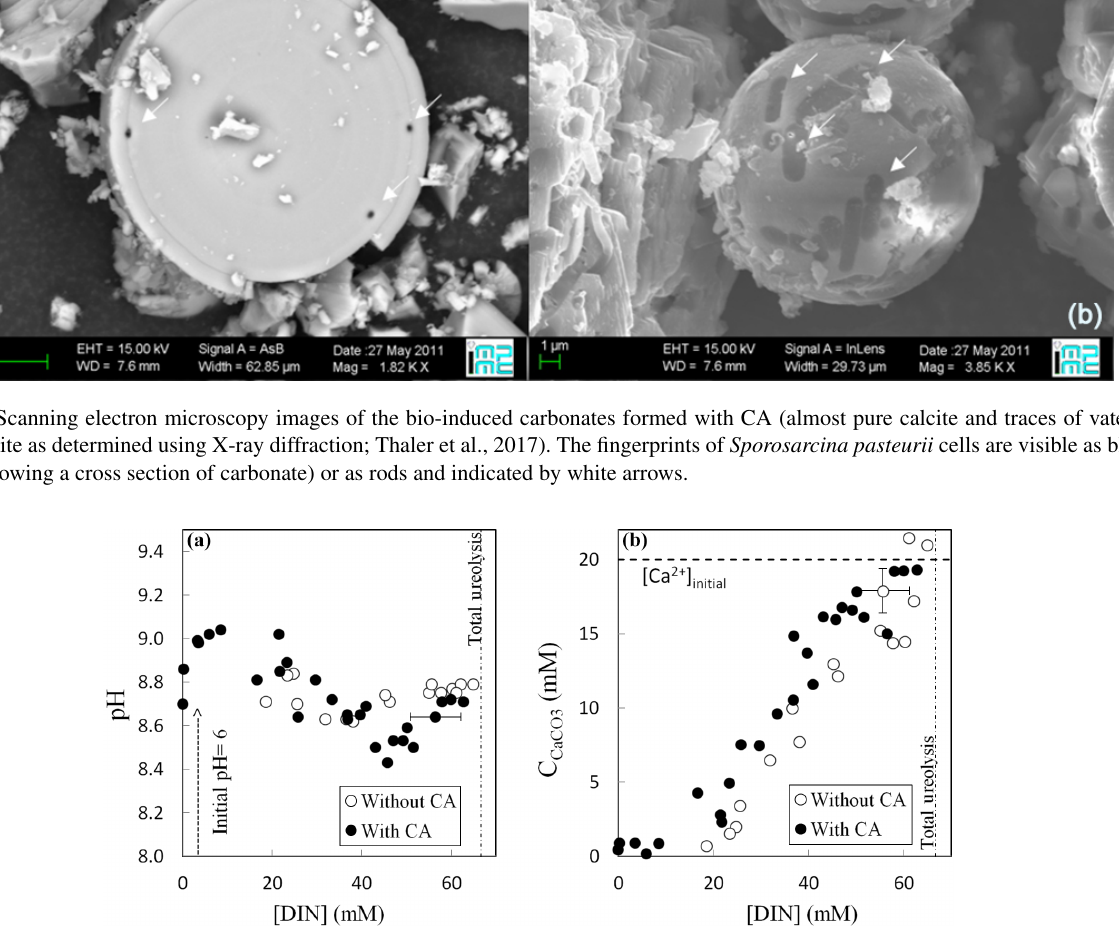
Figure 2. Evolution of pH (a) and amount of precipitated calcium carbonate C CaCO (b) as a function of the production of dissolved inorganic 3 nitrogen DIN (DIN = NH 3 + NH + ) by bacteria during ureolysis, without carbonic anhydrase (CA) (this study) and with CA (data from Thaler 4 et al., 2017). Error bars account for 2SD and are always smaller than symbols for pH values. The mineralogy of the carbonates precipitated with or without CA was determined by X-ray diffraction, indicating that solid carbonates are mostly composed of calcite (including up to 8% of low-Mg calcite, (Mg 0 . 064 , Ca 0 . 936 )CO 3 ), vaterite (2%–4%) and aragonite (1%–4%) (Thaler et al., 2017). The influence of mineralogy on isotopic measurements and temperature estimates is discussed in the Supplement, Sect.